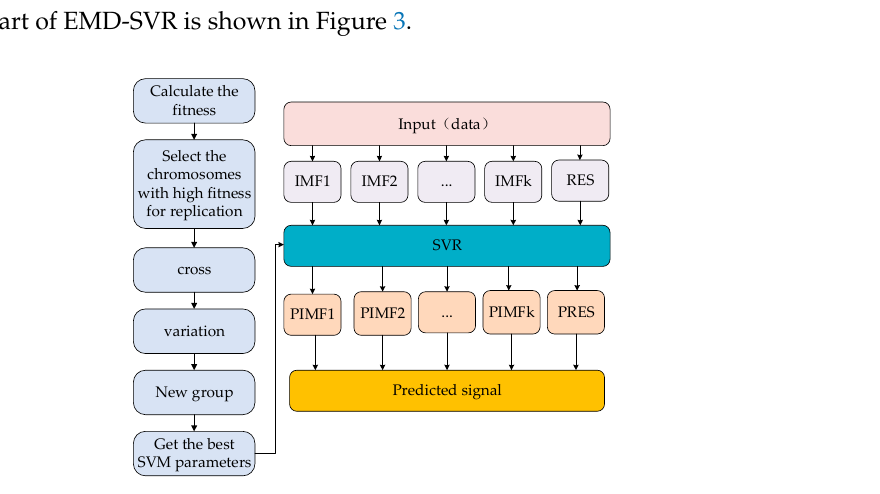
Table 2. Main technical parameters of the continuous casting machine.